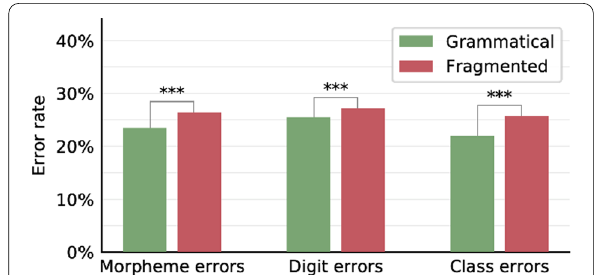
Fig. 7 Results of Experiment 5. In the grammatical condition, each pair of triplets was merged by the word “thousand.” In the fragmented condition, the word “thousand” was misplaced at the end of each stimulus (number-word sequence). Supporting the idea of a cross-triplet representation, i.e., that the number’s syntactic representation can merge words from two different triplets, the morpheme error rate, digit error rate, and class error rate were lower in the grammatical condition than in the fragmented condition. Asterisks denote the significance of the Condition factor in the linear mixed model described in the text (all p <